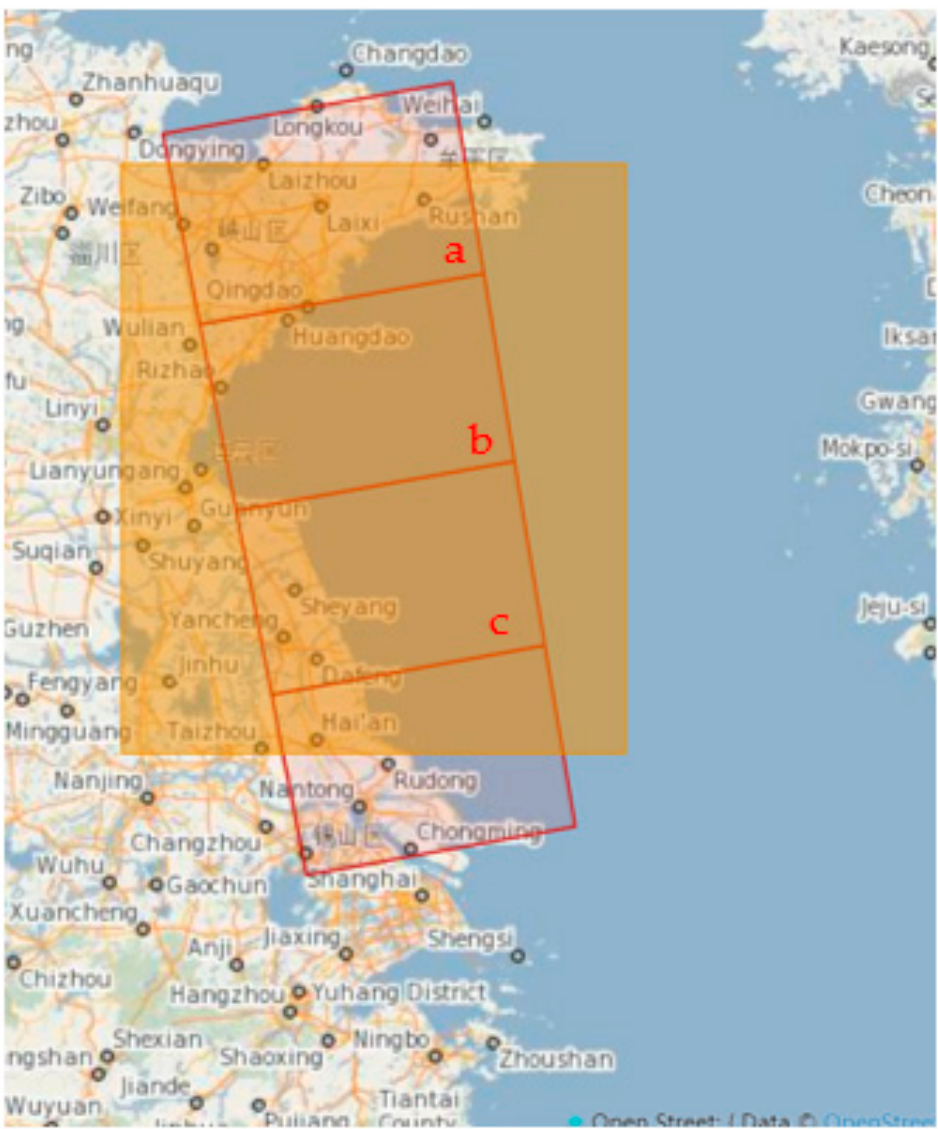
Figure 6. SAR image distribution in the South Yellow Sea. ( a ) Qingdao, ( b ) Rizhao and Liangungang, and ( c ) Yancheng and Nantong.